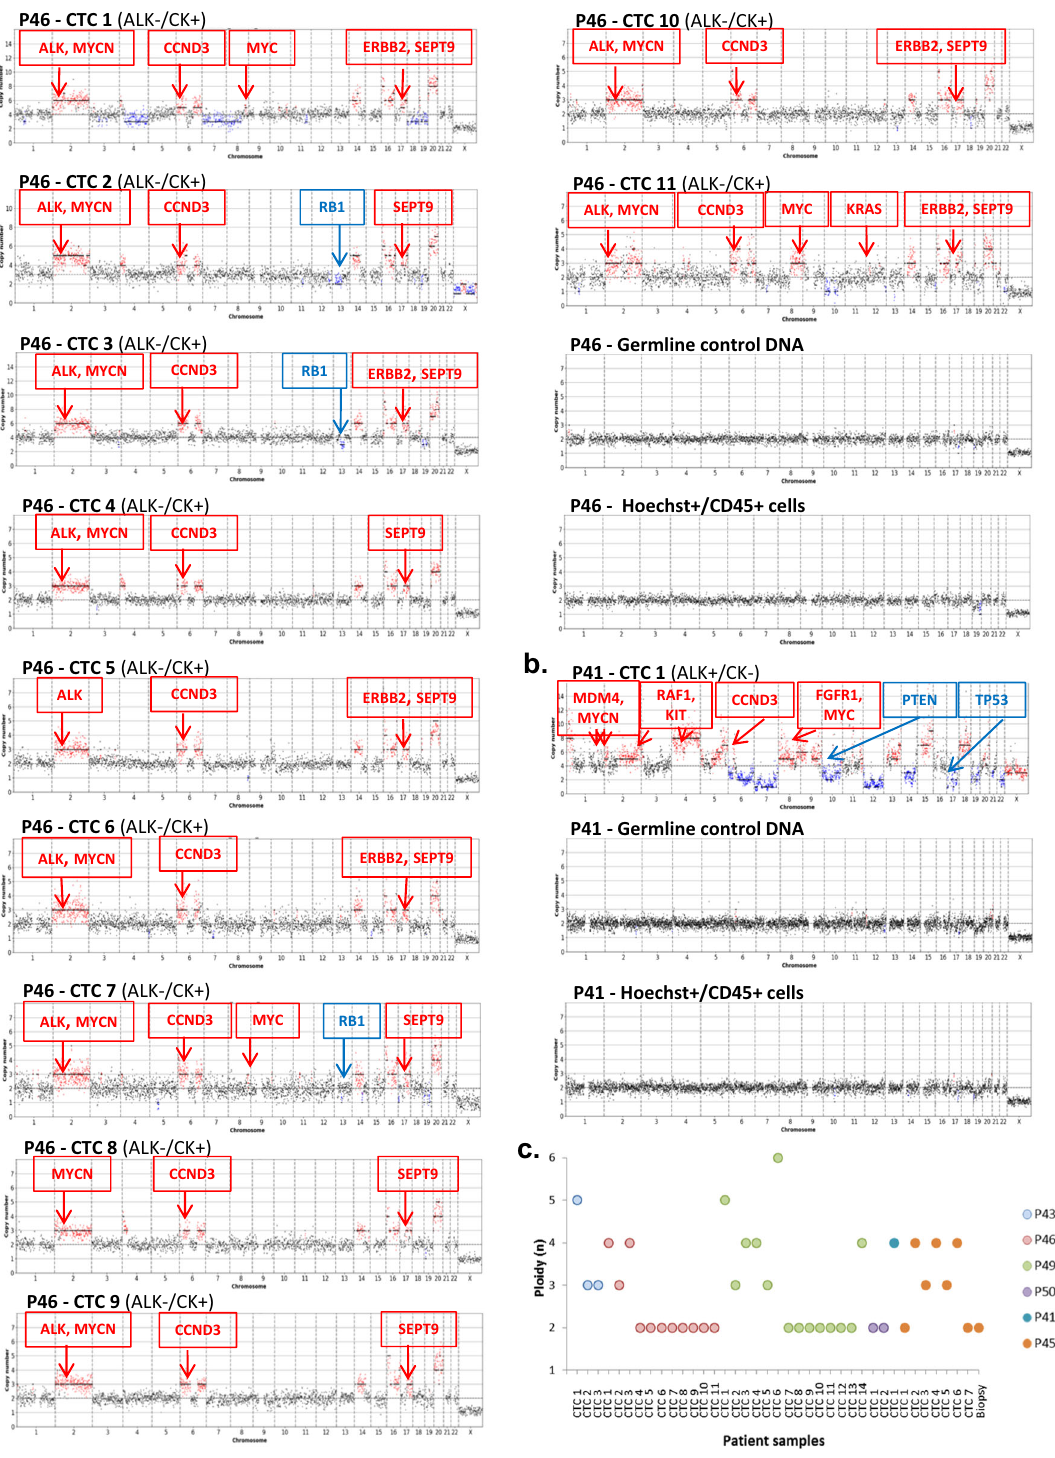
Fig. 2 Low-pass whole-genome CNA pro fi les and ploidy of CTCs. CNAs in predominant pathways are annotated (gain in red, loss in blue). a CNA pro fi les of CTCs, corresponding leucocytes, and germline DNA from patient P46 resistant to crizotinib. b CNA pro fi le of CTC, corresponding leucocytes, and germline DNA from patient P41 resistant to lorlatinib. c Ploidy determined for each CTC sample. P43 samples contain pools of 5 (CTC 1) or 10 (CTC 2, CTC 3) CTCs. CTC 1 of P46 is a pool of 2 CTCs. All other samples are single